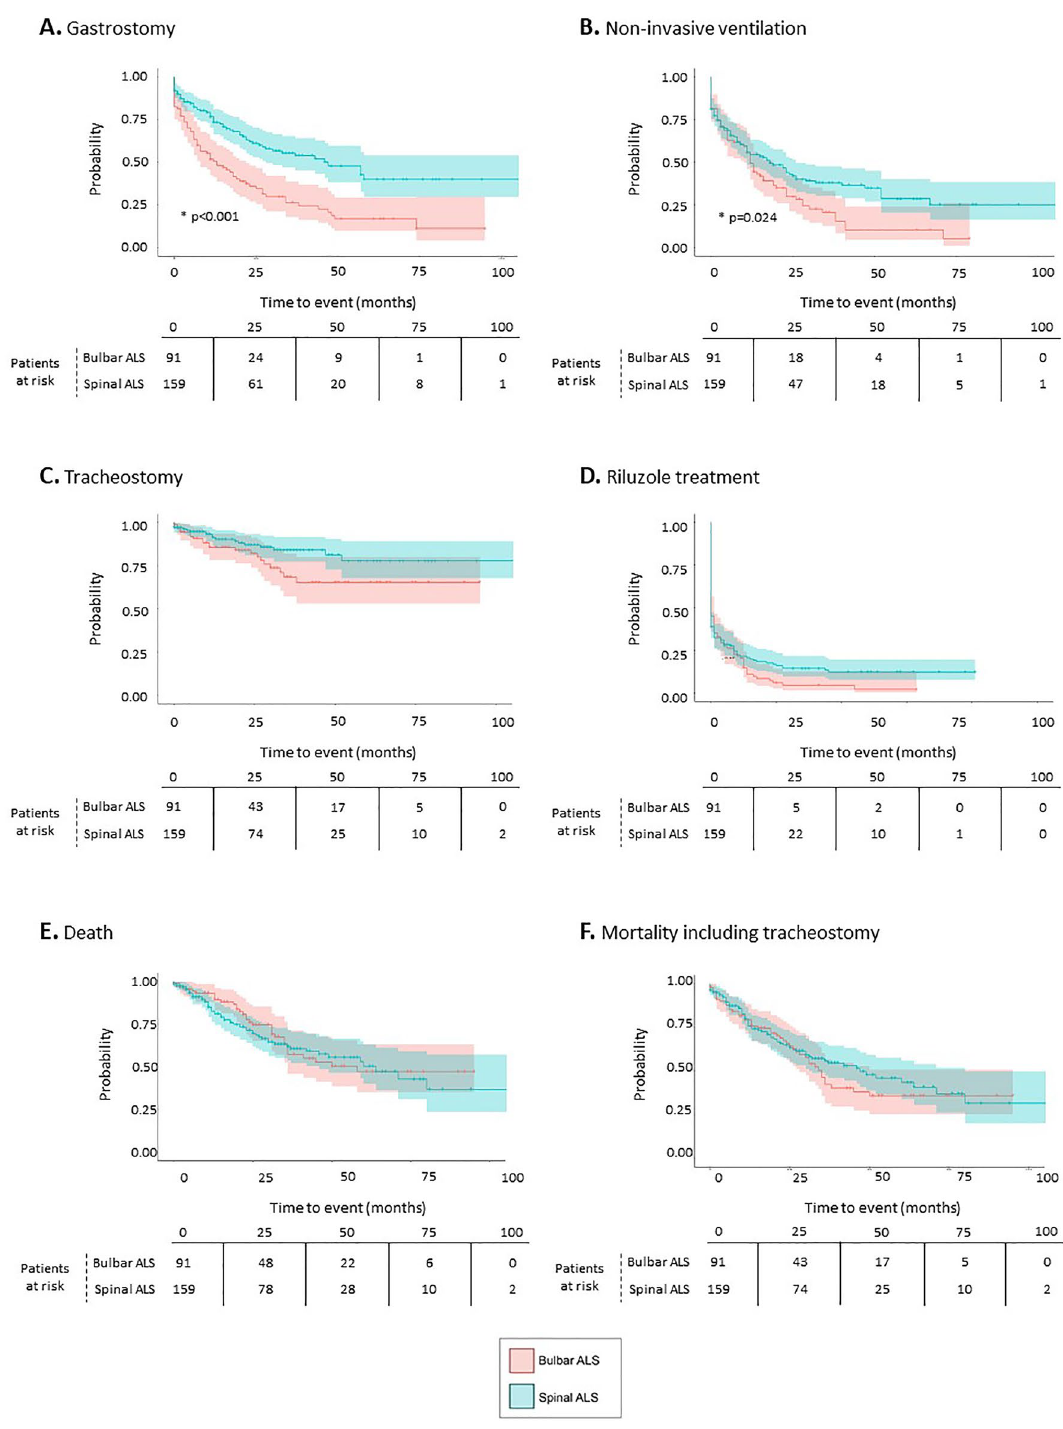
Figure 2. Probability of disease-specific clinical events over time during the follow-up period. Probability for gastrostomy ( A ), non-invasive ventilation ( B ), tracheostomy ( C ), riluzole treatment ( D ), death ( E ) and mortality including tracheostomy ( F ) during follow up. Data are shown for patients with bulbar ALS (orange) and patients with spinal ALS (green). The number of patients at risk (same for all categories) across the follow-up period is indicated below. Shaded areas indicate confidence intervals (CI). *Denotes significant difference across subgroups (P <